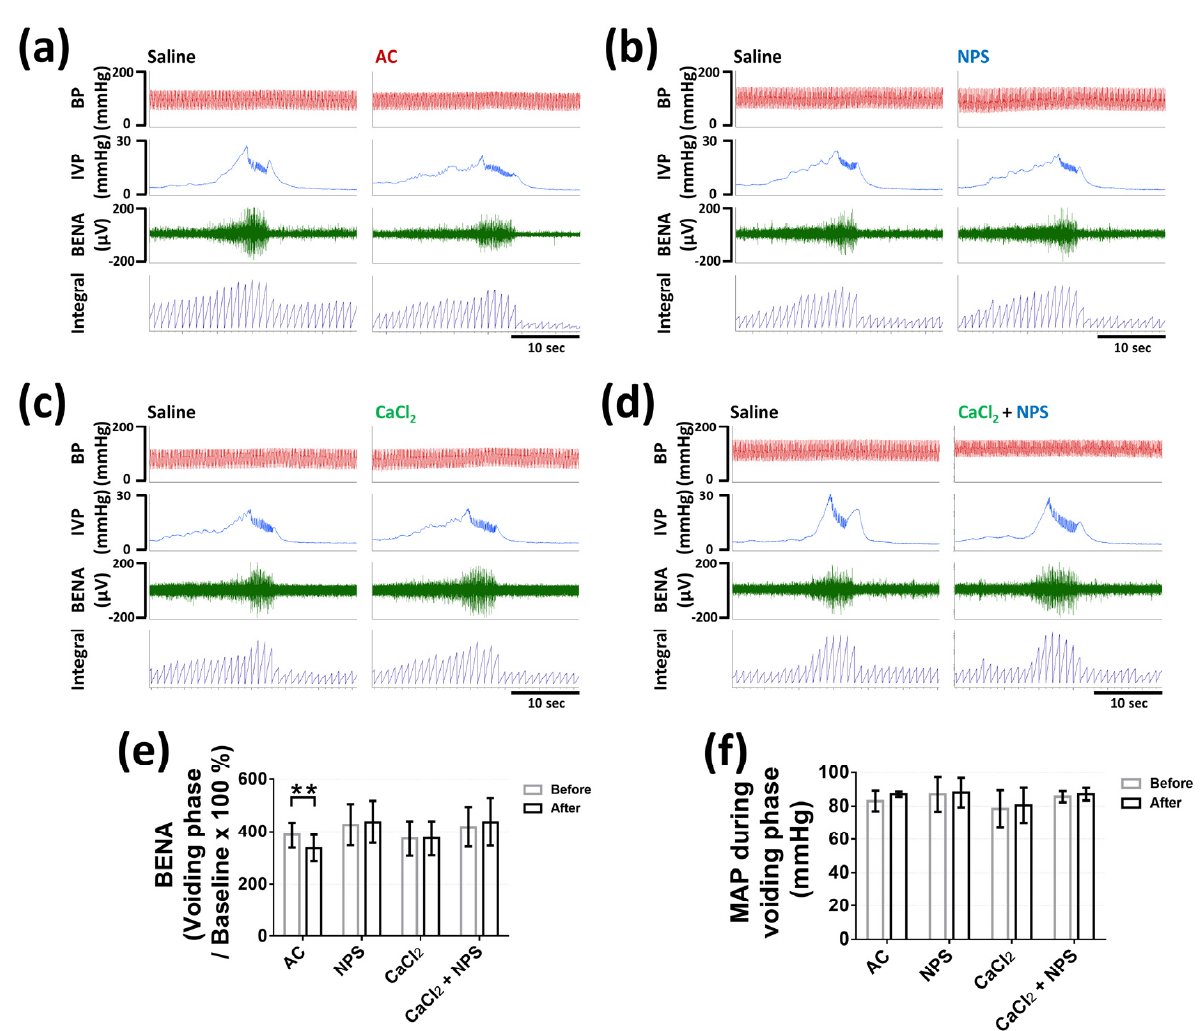
(Figure 6f) and the voiding phase ( p = 0.2974, p = 0.9847, p = 0.8309, p = 0.9364 in AC, NPS, CaCl 2 , and CaCl 2 + NPS treatments, respectively) (Figure 7f).